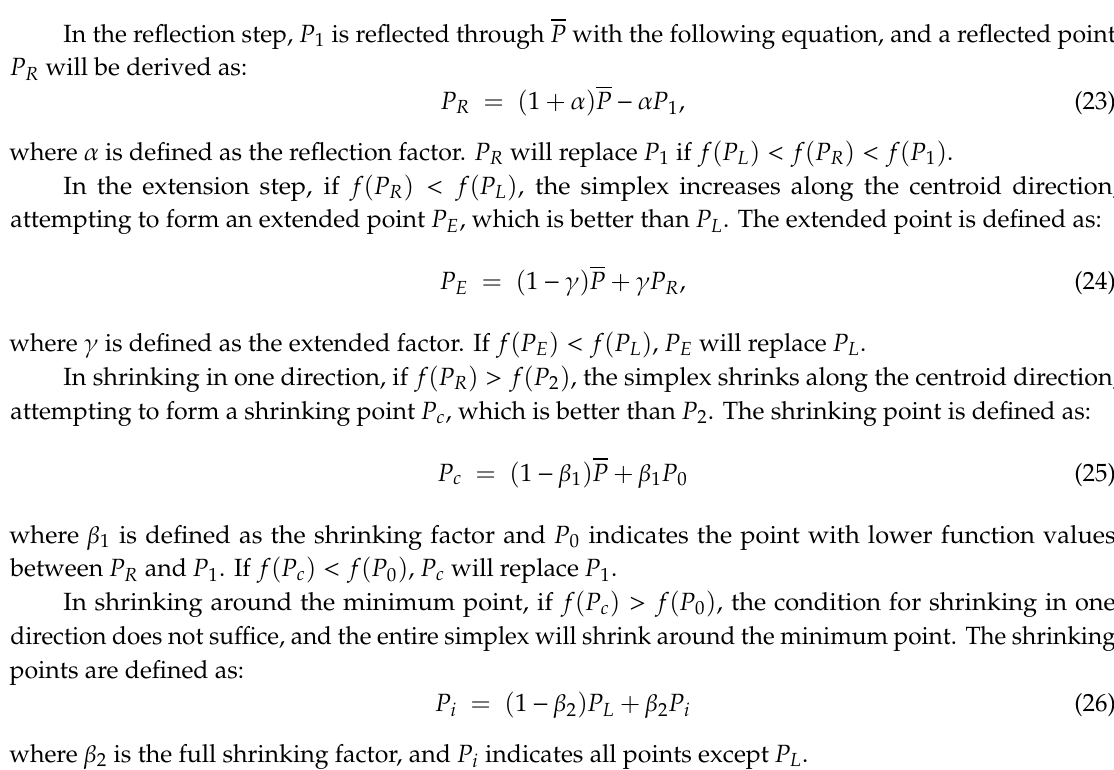
Figure 8. Flow diagram of the Nelder-Mead method.